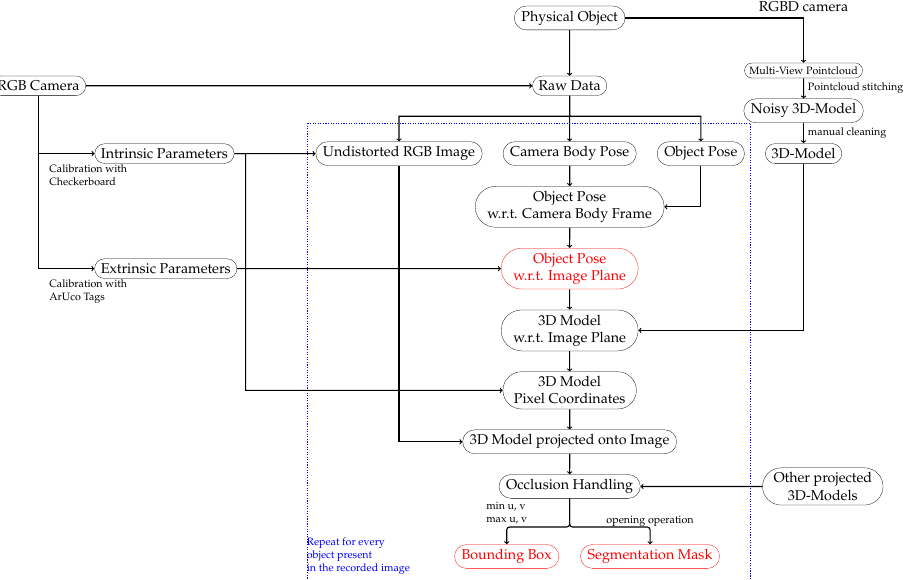
Figure 7. High-level visualization of our data collection and annotation pipeline. For simplicity reasons the pipeline shows the process from the point of view from a single object. However, it should be noted that the part enclosed by the blue rectangle is executed for every frame and then for each object present in the current frame. First, the 6-DoF pose of the object w.r.t., the world frame is mapped to the frame of the image plane, and afterward, using the previously created 3D-model, the pixel coordinates are calculated. The final step consists of occlusion handling and then generating the bounding boxes and binary segmentation masks. On the other hand, every step outside the blue rectangle, namely camera calibration and 3D-model generation, has to be performed only